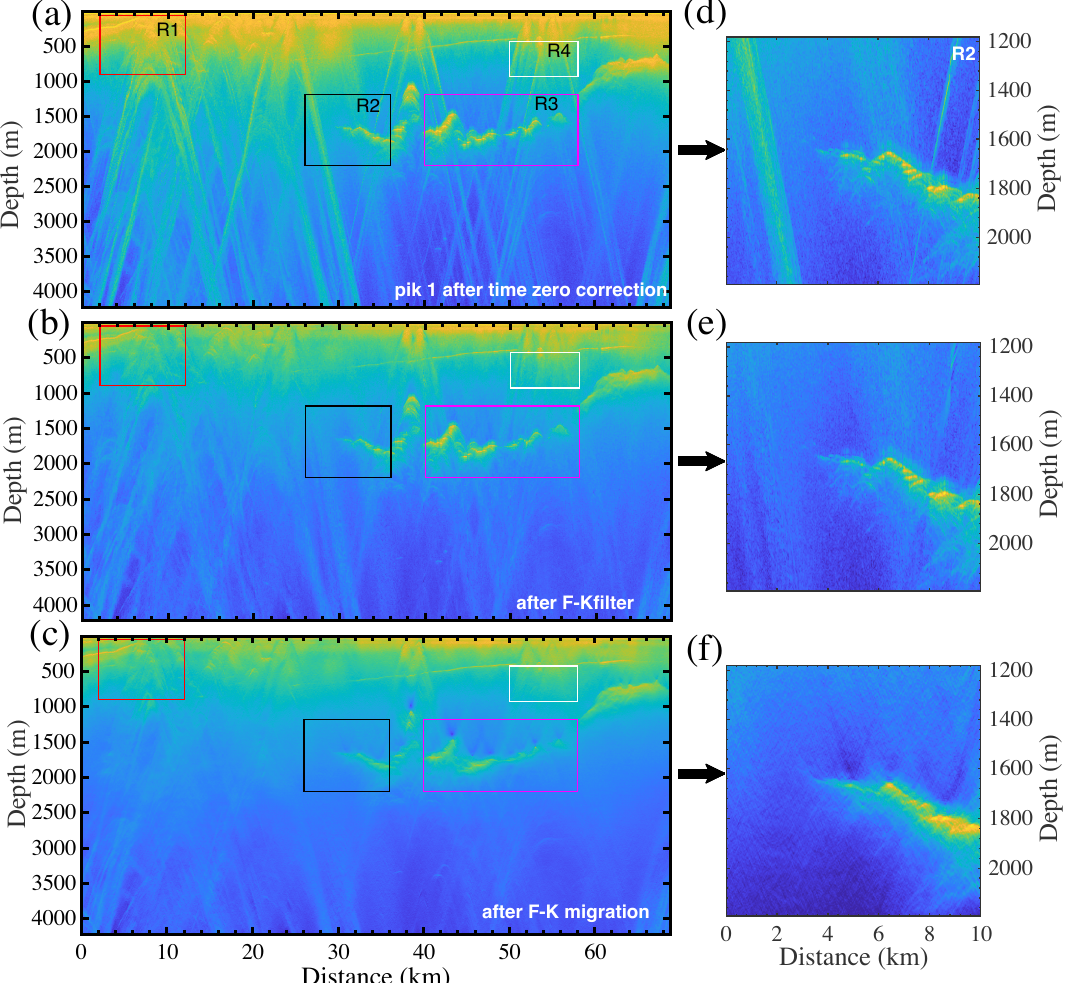
Figure 3. Radar data and processing results of Line 2 (AMY data). ( a – c ) are the results of time zero correction (two-dimensional interpolation and removal of the air layer signal), F–K filtering, and F–K migration in the processing sequence. The rectangular boxes in the profile are the four areas selected for quantitative evaluation index calculation (R1—red; R2—black; R3—magenta; and R4—white). ( d – f ) are the corresponding R2 areas in ( a – c ),